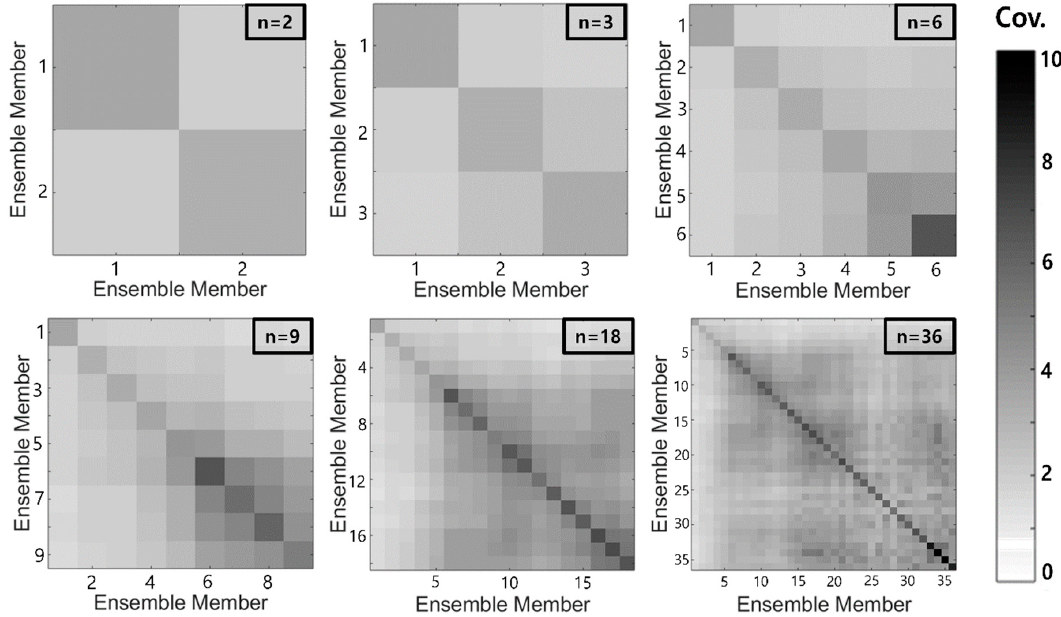
Figure 4. Covariance matrix derived from all the available rainfall forecasts with ensemble members 2, 3, 6, 9, 18, and 36 on 04:30, 11 September 2017.